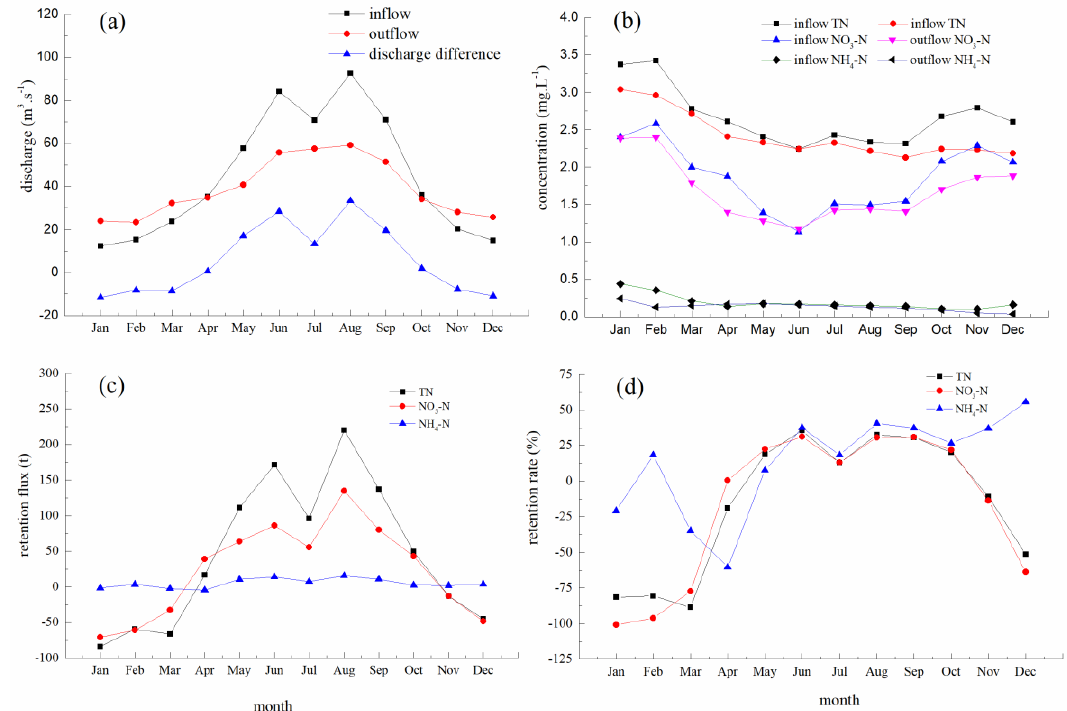
Figure 4. Monthly variation of hydrological condition and nitrogen retention effects in Shanmei Reservoir. ( a ) Discharge of inflow and outflow; ( b ) nitrogen concentration of inflow and outflow; ( c ) retention flux of TN, NO 3 -N, and NH 4 -N; ( d ) retention rates of TN, NO 3 -N, and NH 4 -N.